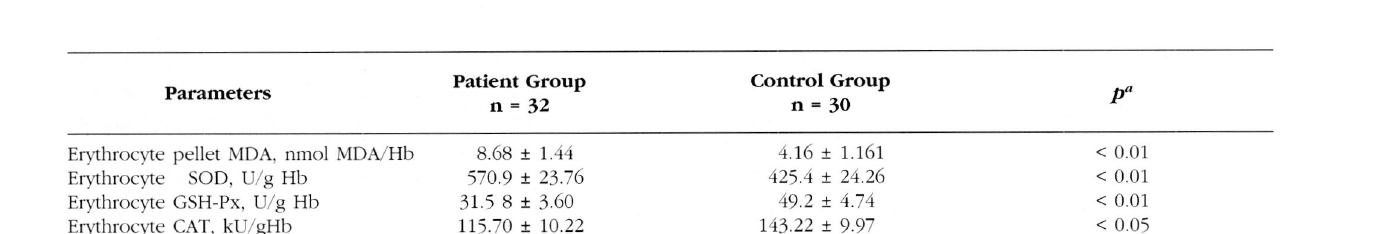
Table II. - Comparative analysis of lipid peroxidation of - as assessed by MDA content - and the monitoring of three anti-oxidant enzymes in erythrocytes recovered from either healthy subjects or patients with active cutaneous